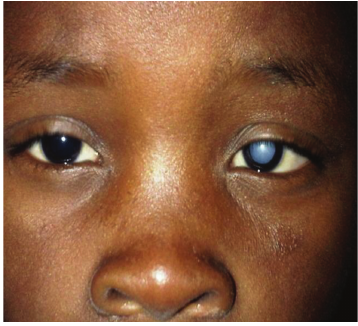
Figure 3: A dense left